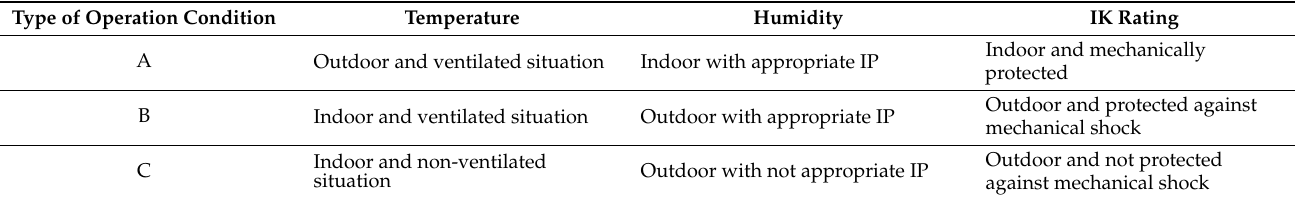
Table 5. Type of operation conditions for temperature, humidity and